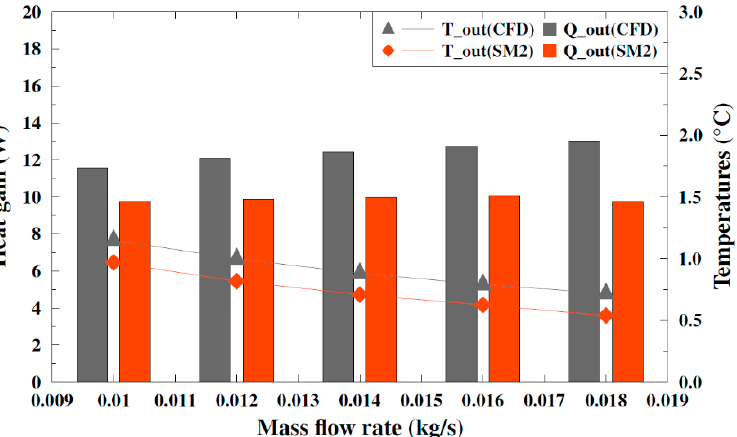
Figure 16. Variation in the temperature and heat gain of the air at the outlet with mass flow rate (no solar radiation).